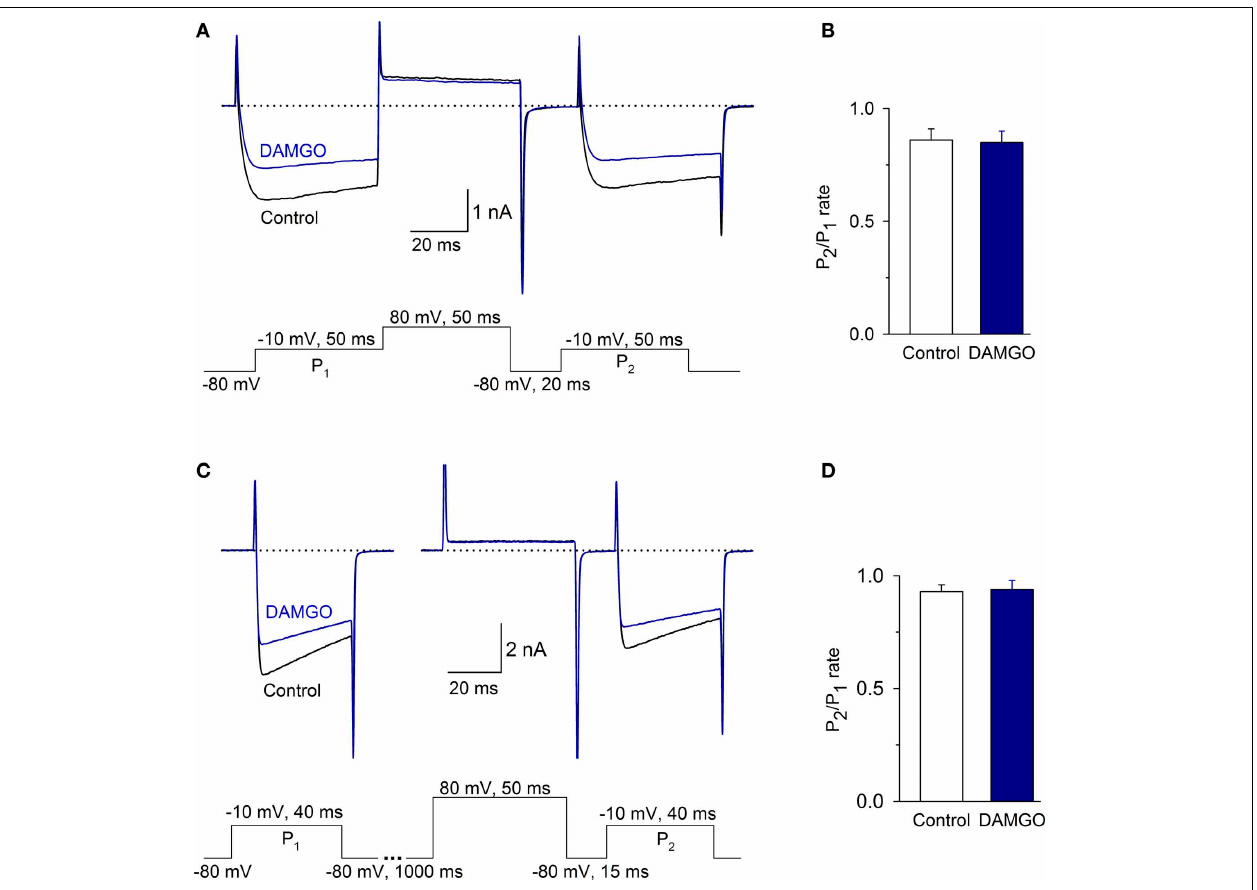
showing the value of the P 2 / P 1 ratio under control and after DAMGO. (C) The time between P 1 and the pulse to 80mV was 1s to avoid inactivation accumulation. The ratio P 2 / P 1 did not change between the control and after DAMGO application, independent of the time between P 1 and the pulse to 80mV. (D) Bar graph showing the value of the P 2 / P 1 ratio under control and after DAMGO.